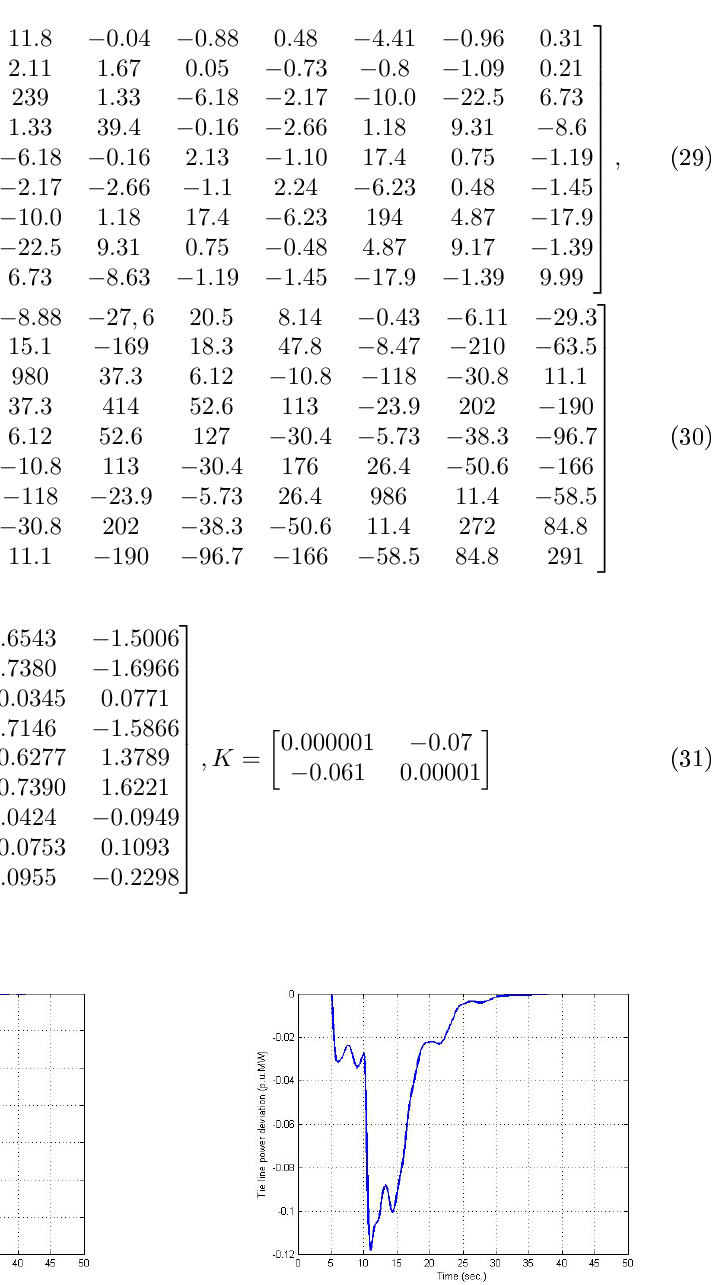
of controller against parameter uncertainties.